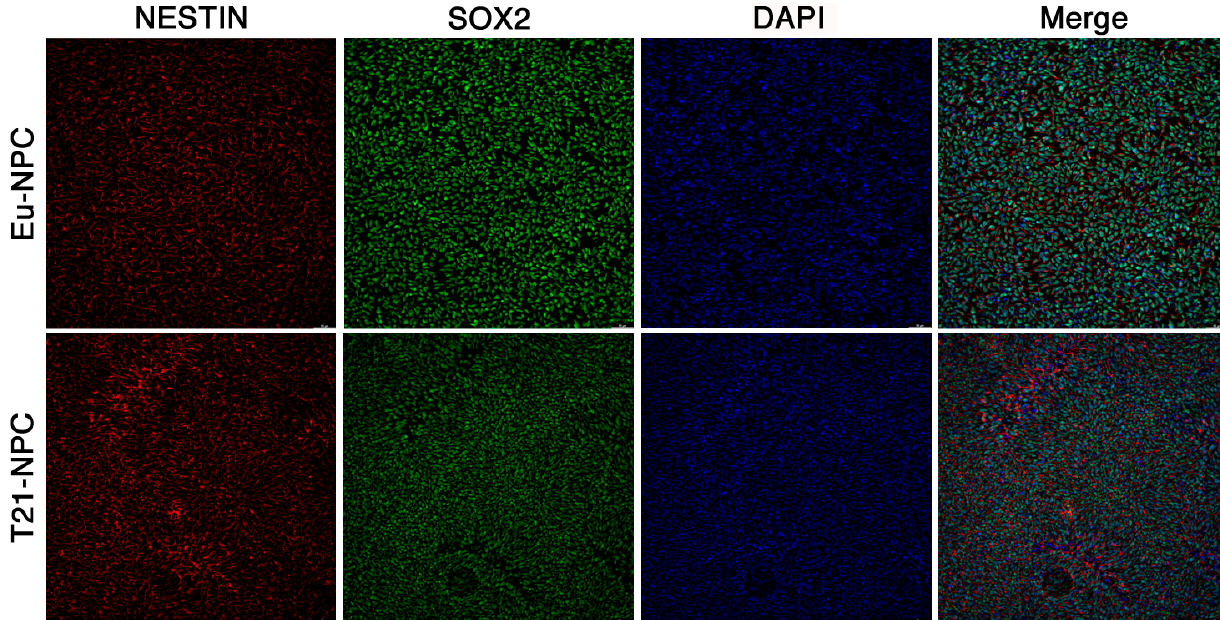
Figure 6. Low magnification acquisition of NESTIN and SOX2 positive NPCs. Euploid and trisomic NPCs were stained by double immunofluorescence with anti-NESTIN and anti-SOX2 antibodies at seven days of culture in differentiation medium. Fluorescent images were taken by the Thunder Imaging Systems. T21-NPC images are representative of the two trisomic clones. Eu-NPCs and T21-NPCs are positive when stained with either the NESTIN antibody (red) or the SOX2 antibody (green). Nuclei are also stained with DAPI (blue). Note the uniform staining of NESTIN and SOX2. Bar = 50 μ m.